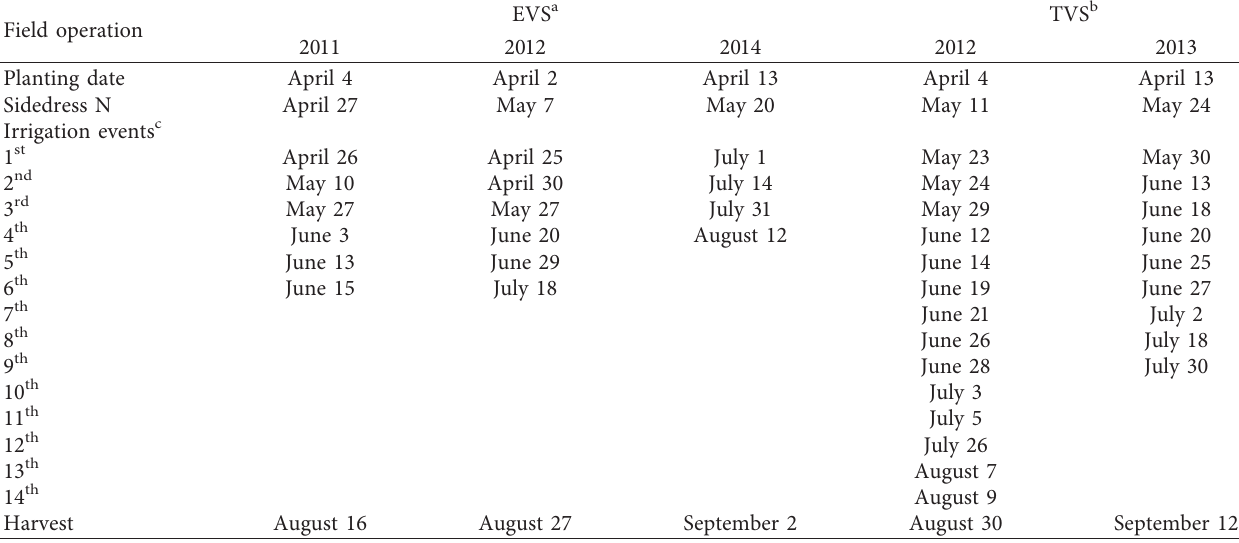
Table 2: Dates for select cultural practices that include planting, sidedress N, irrigation, and harvest at five site-years during the 2011 to 2014 growing seasons across northern and central